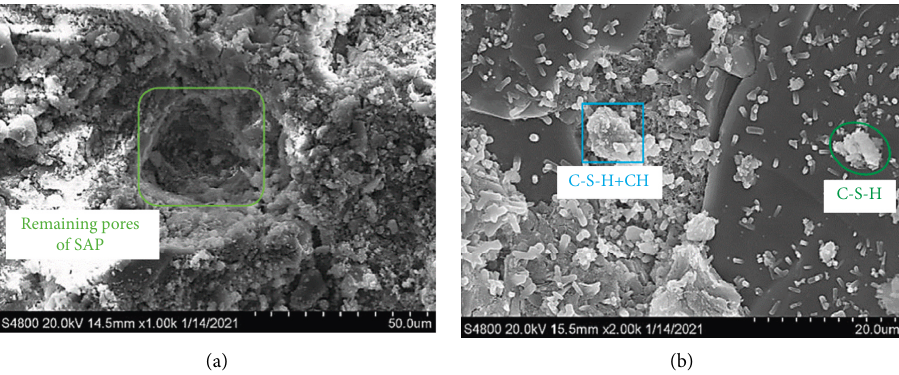
Figure 17: Remaining pores formed by SAP gels panorama of S-100-0.200%: (a) 28d; (b)